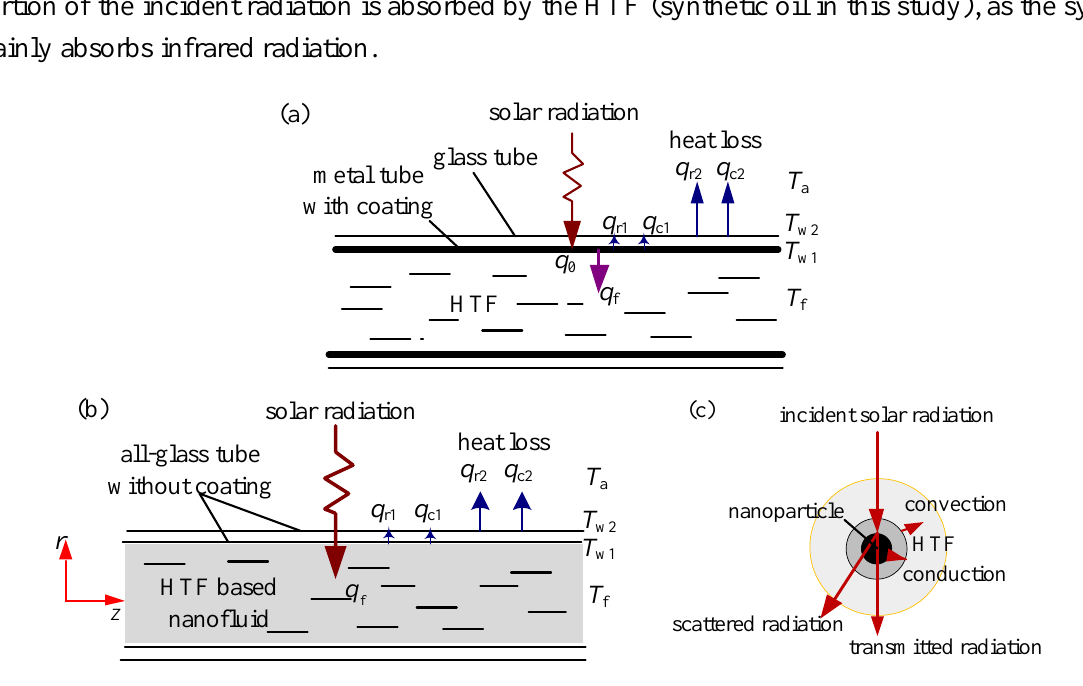
Figure 2. Schematics of solar collection principles. ( a ) A conventional indirect absorption solar collector (IASC); ( b ) The proposed novel nanofluid-based direct absorption solar collector (NDASC); ( c ) The heat transfer around nanoparticles inside the tube of